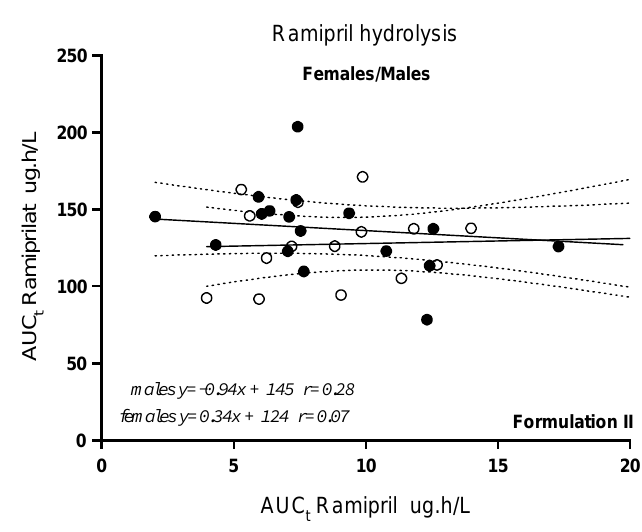
FIGURE 2. AUC t ramipril plotted vs. the AUC t of the metabolite ramiprilat after the oral administration of 5 mg ramipril (Formulation II) to male and female subjects. There is a 7-fold variation in the AUC t ramipril, with a 1.5-fold variation in the AUC t of the metabolite. No difference between males (solid dots) and females (open dots) in the hydrolysis of ramipril Formulation II ( p = 0.93). Similar results were obtained for Formulation I ( p = 0.93). The hydrolysis of ramipril in ramiprilat must be instantaneous, or by the gastrointestinal tract, because when extrapolating to t = 0 ( lim X → 0 ), there is a substantial amount of ramiprilat present with no measurable AUC t of the parent drug.